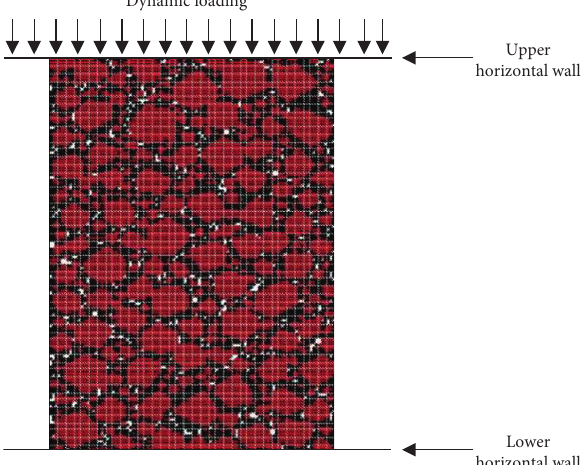
Figure 9: Dynamic modulus numerical